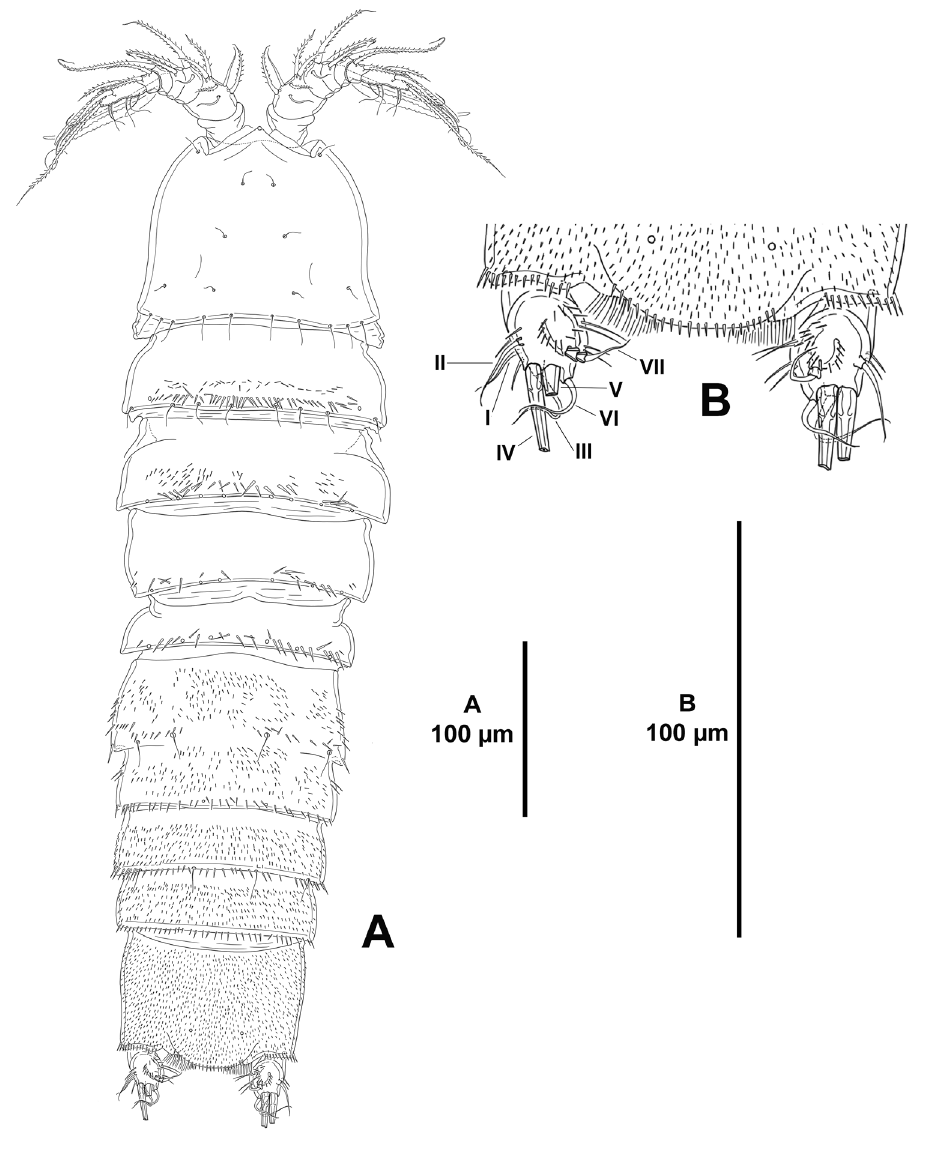
Figure 8. Odiliacletodes secundus sp. n., female holotype. A habitus, dorsal B posterior part of anal somite and caudal